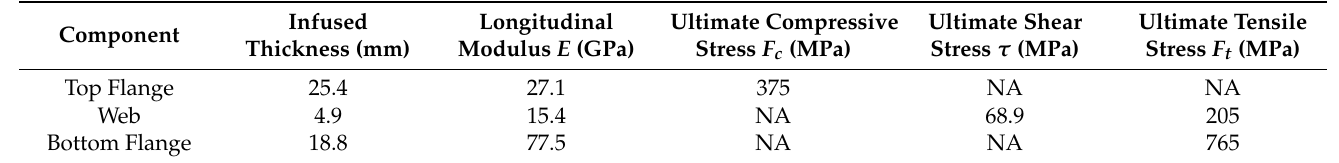
Table 1. FRP Mechanical Design Properties.